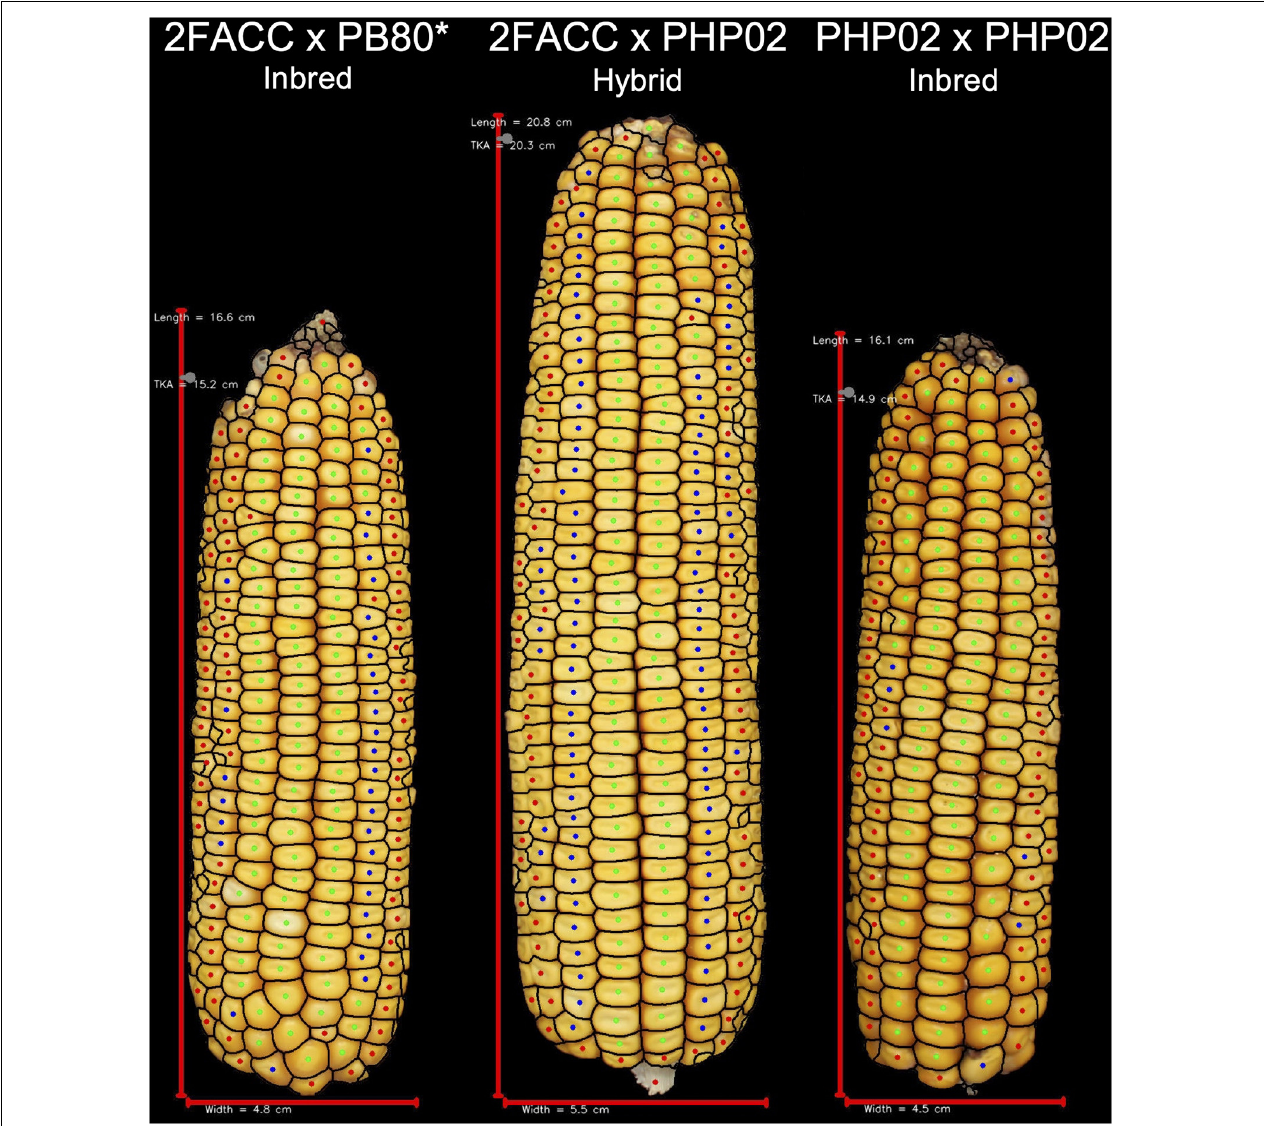
FIGURE 6 | Visual description of hybrid breeding. Inbred line 2FACC, on the left, from the Stiff Stalk heterotic group and inbred line PHP02, on the right, from the Iodent heterotic group show reduced vigor due to inbreeding depression. The hybrid of these inbred lines displays greater yield potential than either inbred parent due to hybrid vigor. *2FACC inbred was not produced in this study. As the progenitor of 2FACC, PB80 produced a highly inbred line when crossed to